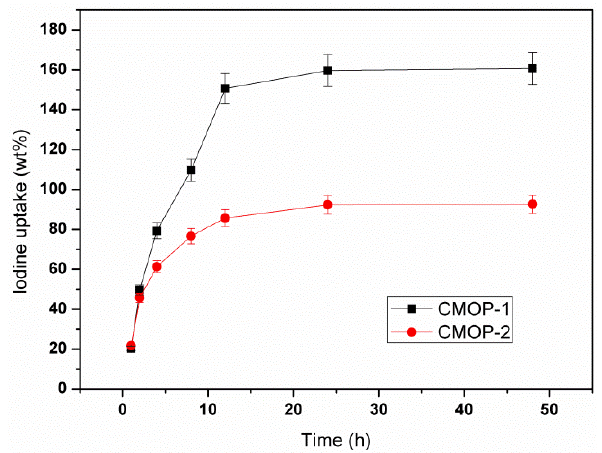
Figure 4. The uptake of I 2 vapor at 353 K.